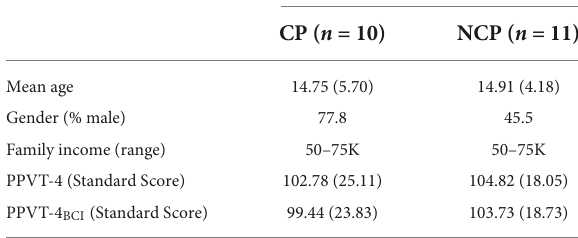
TABLE 1 Demographics and PPVT-4 scores by age and diagnostic